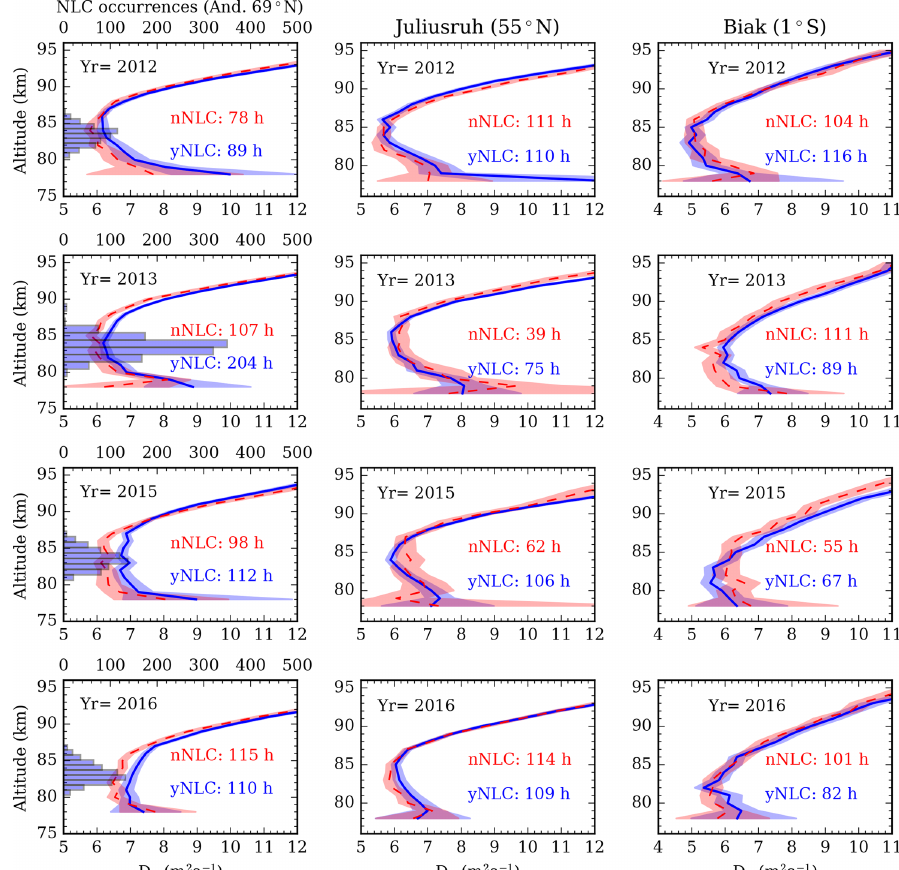
Figure 3. Mean meteor trail diffusion coefficients after segregating them based on the presence of NLC (yNLC, blue) and non-NLC (nNLC, red) over Andenes station (leftmost column) are shown. Using the time sampling from NLC occurrences at Andenes, the D a measurements at midlatitude (Juliusruh; middle column) and low latitude (Biak; right column) are also grouped. The shaded regions around the averaged vertical profiles, dashed for nNLC and continuous for yNLC, are the 95% confidence intervals. The histograms in the top axes of the leftmost column show the altitude variability of NLC occurrences measured using RMR lidar at Andenes during June–July–August. Notable features are that (i) D a under yNLC is enhanced compared to nNLC conditions, (ii) NLC-based grouping does not show separations or enhancements at middle and low latitudes, and (iii) the high-latitude enhancements are predominantly at NLC peak